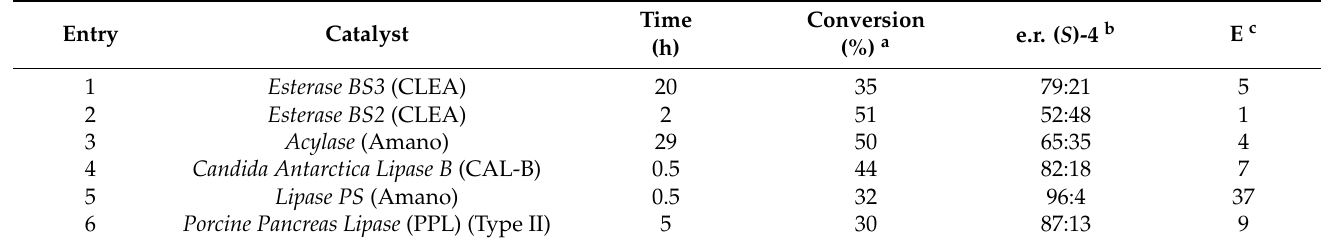
Table 2. Results from screening of enzymes for the hydrolysis of racemic 5